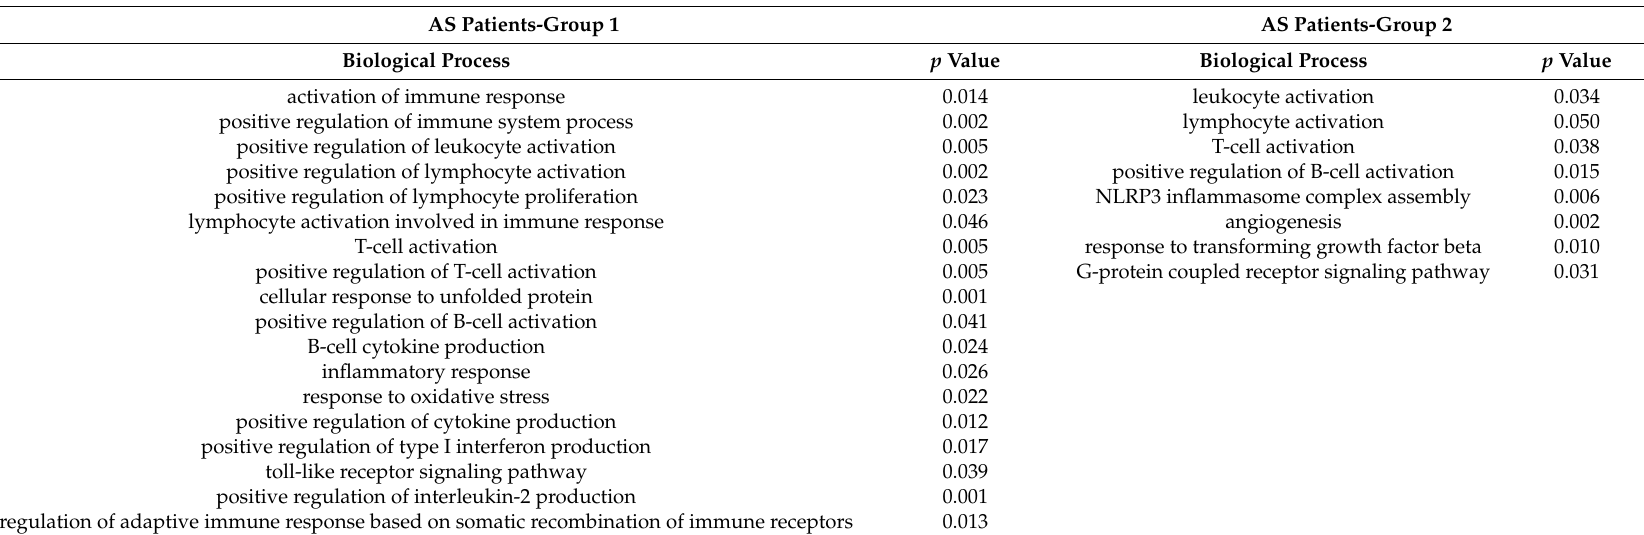
Table 7. Biological processes that were significantly enriched in genes corrected by the